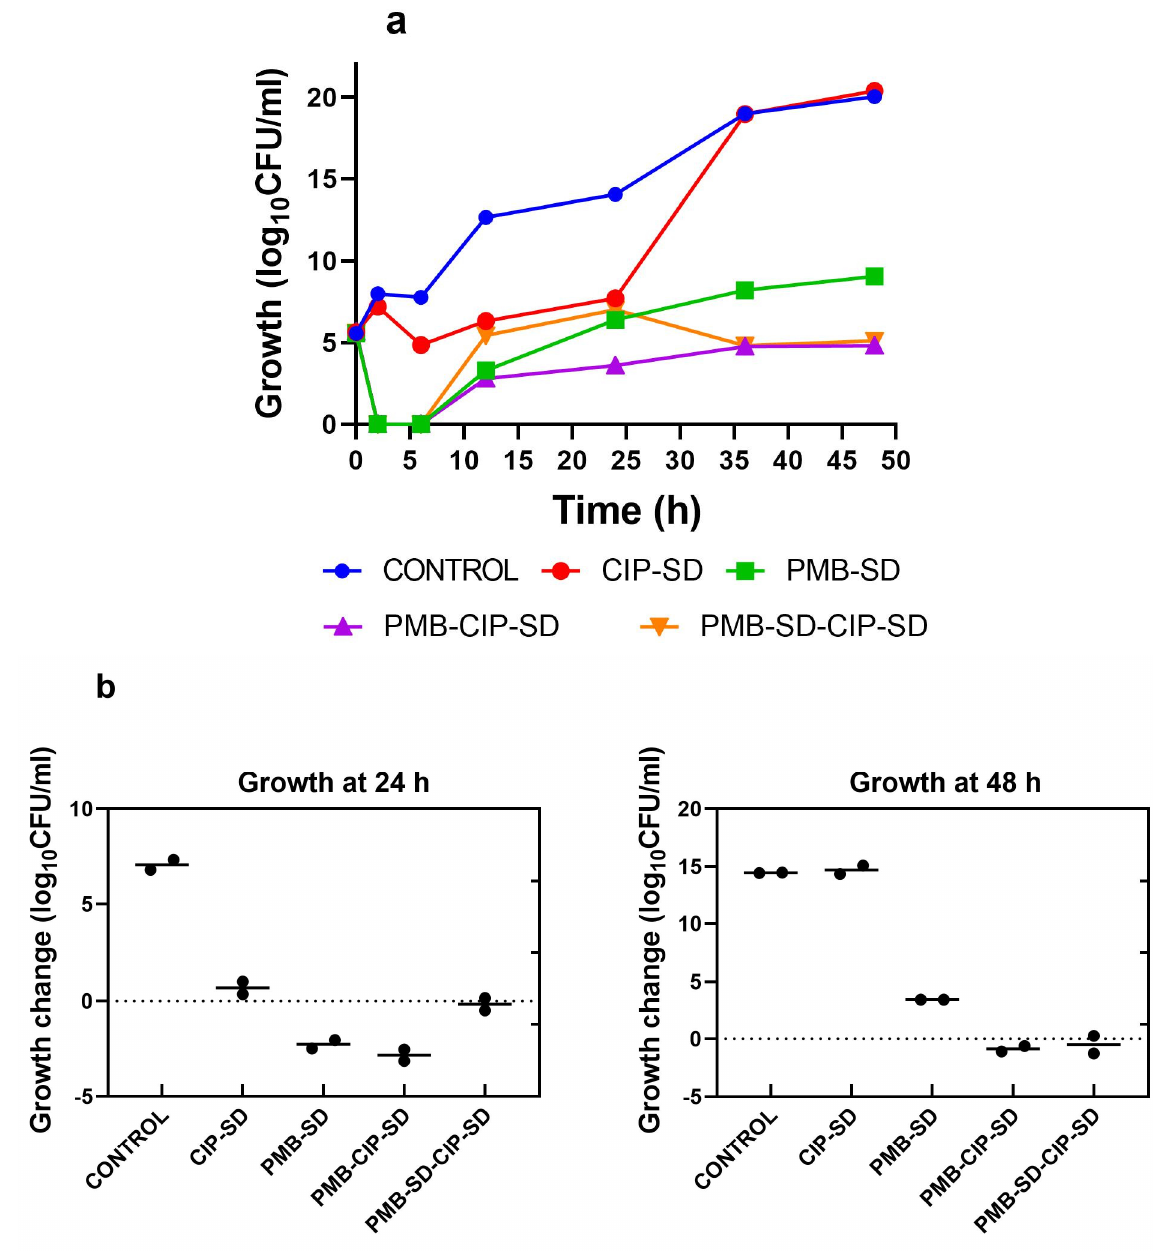
Figure 7. Time–kill assay with A. baumannii K31 treated with different formulations ( a ) and a histogram of the change in growth after 24 h and 48 h incubation compared to the inoculum ( b ). Data are presented as the means of two experiments.